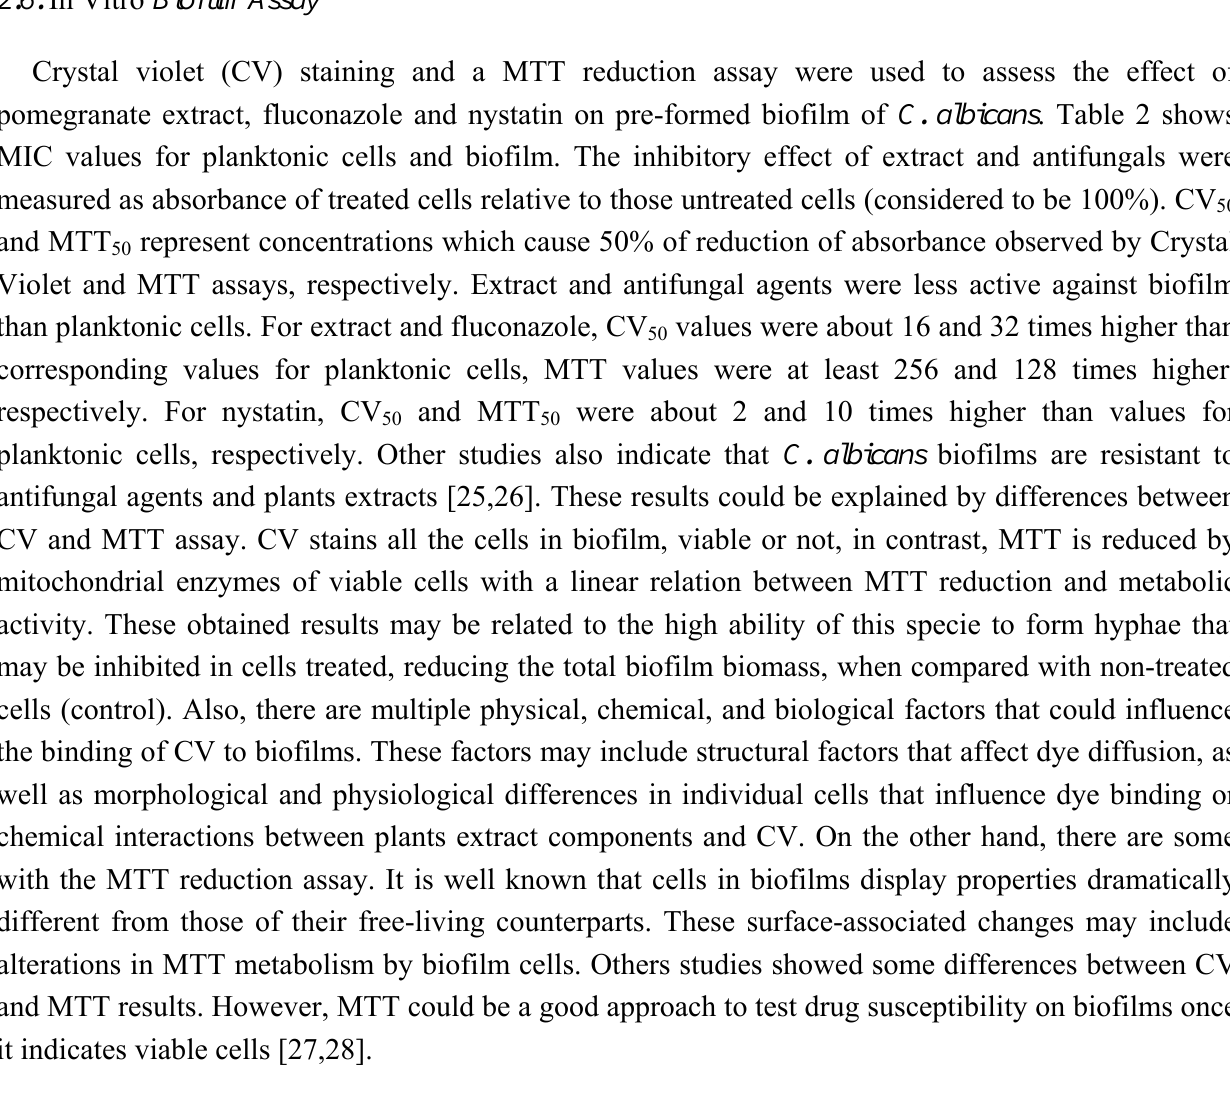
Table 2. MICs of pomegranate extract and antifungal agents against planktonic and biofilm of Candida albicans ATCC